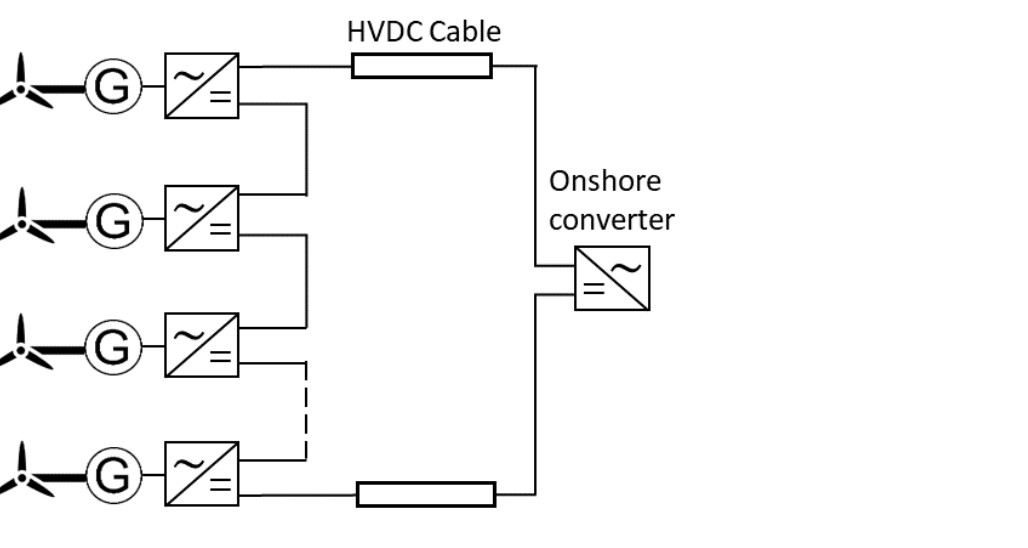
Figure 7. DC collection system with series-connected